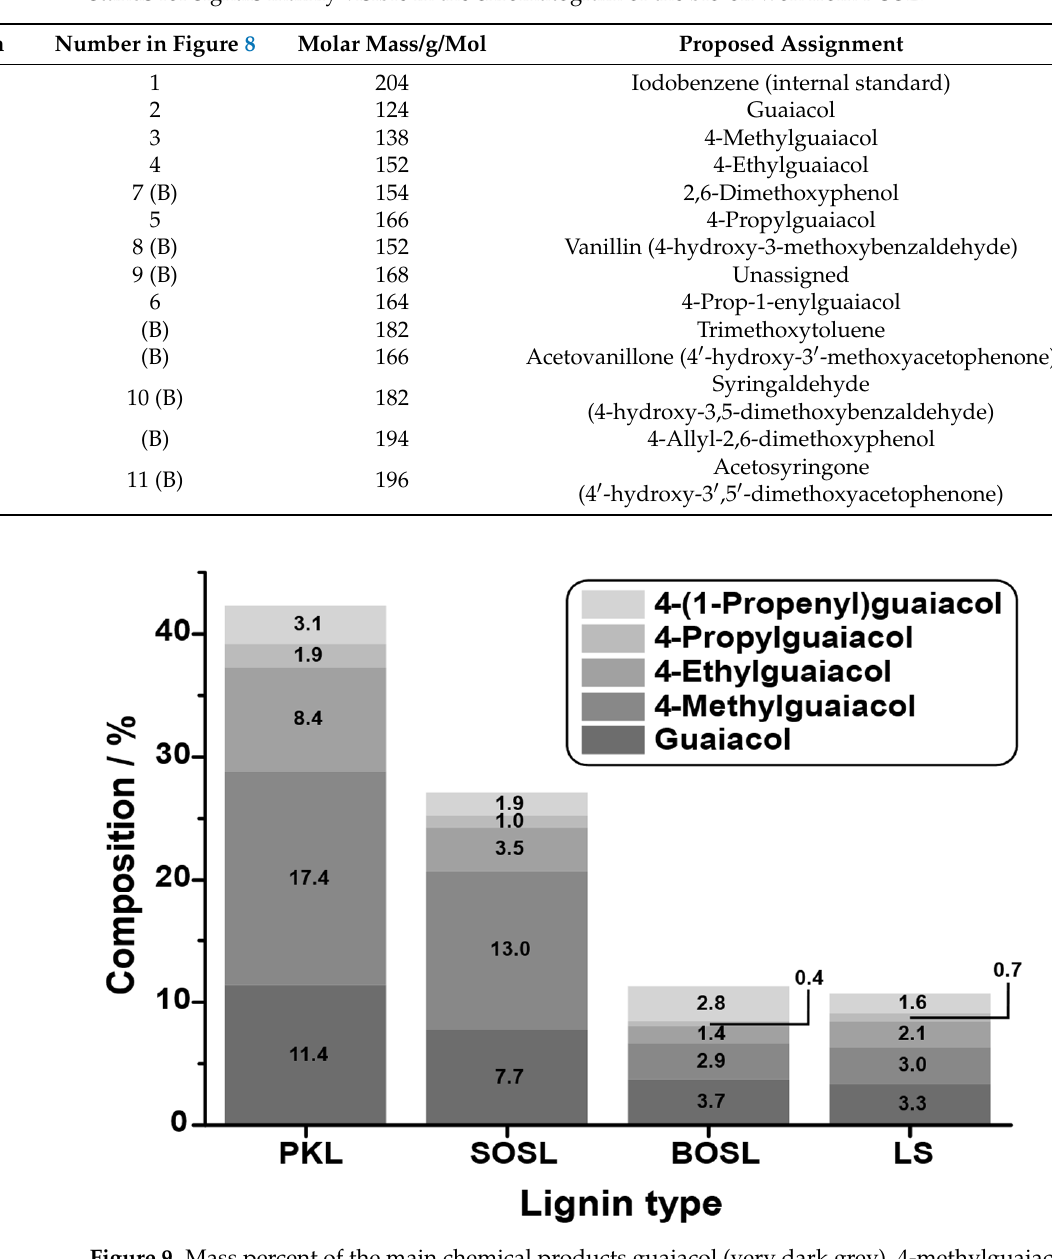
Table 3. Signal assignments and retention times of the chromatograms depicted in Figure 8. (B) stands for signals mainly visible in the chromatogram of the bio-oil won from BOSL.